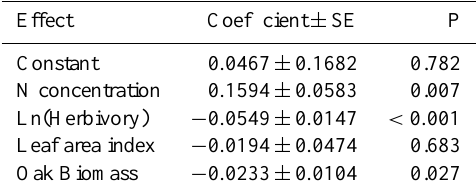
The overall regression is significant ( F 4 , 103 = 8 . 543; P < 0 . 001; adjusted r 2 = 0 .